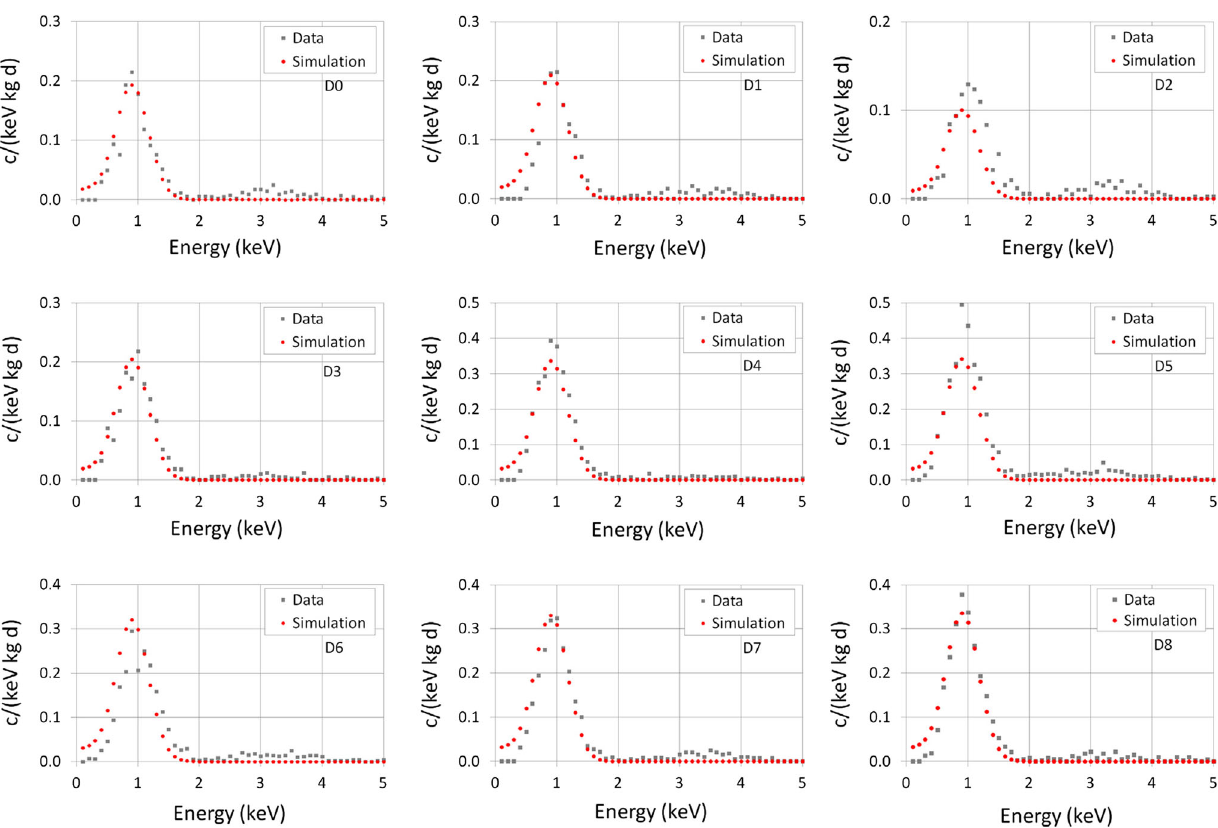
Fig. 5 Comparison for the nine ANAIS-112 detectors in the first year ofdatatakingofthelowenergyspectra(afterfilteringandefficiencycor- rection) in coincidence with the high energy gamma at 1274.5 keV with